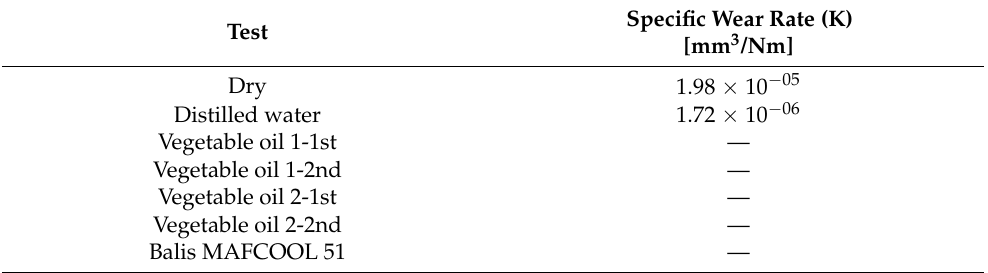
Table 16. Wear results for the alumina